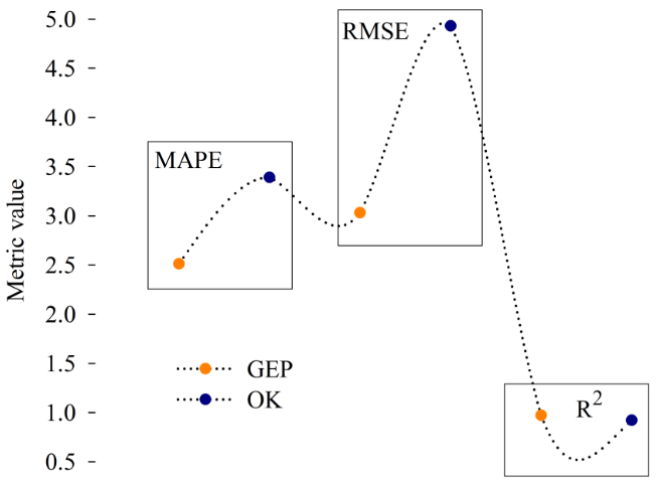
Figure 12. Compared performance of models using statistical error metrics for whole datasets (delete the dot line).